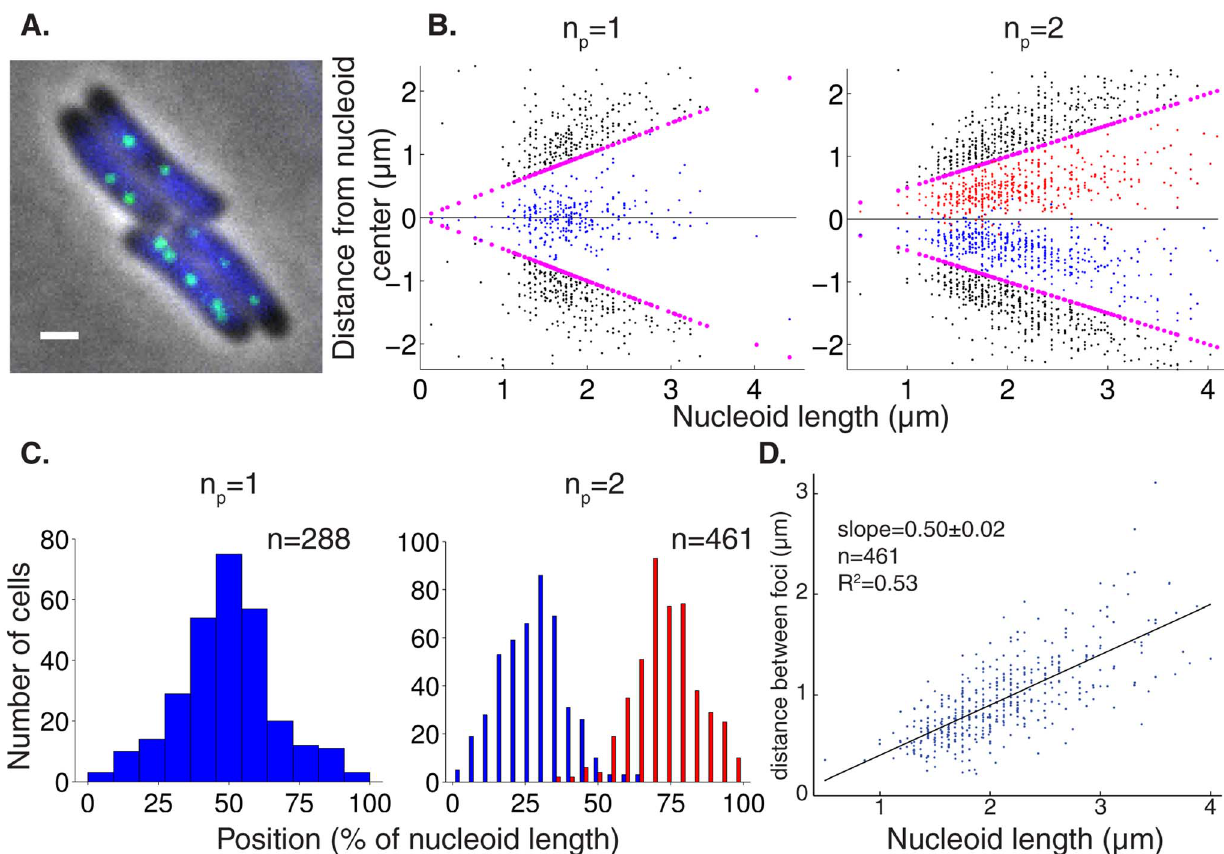
Fig. 1. Plasmid foci are equally spaced over the nucleoid. ( A ) Fluorescence localization of plasmid-binding protein ParB-GFP (green) and Hoechst DNA stain (blue) in representative WT E. coli cells. Scale bars: 1 m m; plasmid: pFS21 (mini-R1, parC1 + , parA + , parB::sfGFP , parC2 + ). ( B ) Scatter plot of plasmid foci positions (blue, red) with respect to nucleoid edges (purple) and cell edges (black) for wild-type cells with n p =1,2 plasmid foci. ( C ) Histograms of plasmid foci positions shown in ( B ) relative to nucleoid length. ( D ) Scatter plot (blue) of the interplasmid focus distance as a function of nucleoid length in cells exhibiting two plasmid foci. A least square fit (black line) indicates a slope of 0.5.